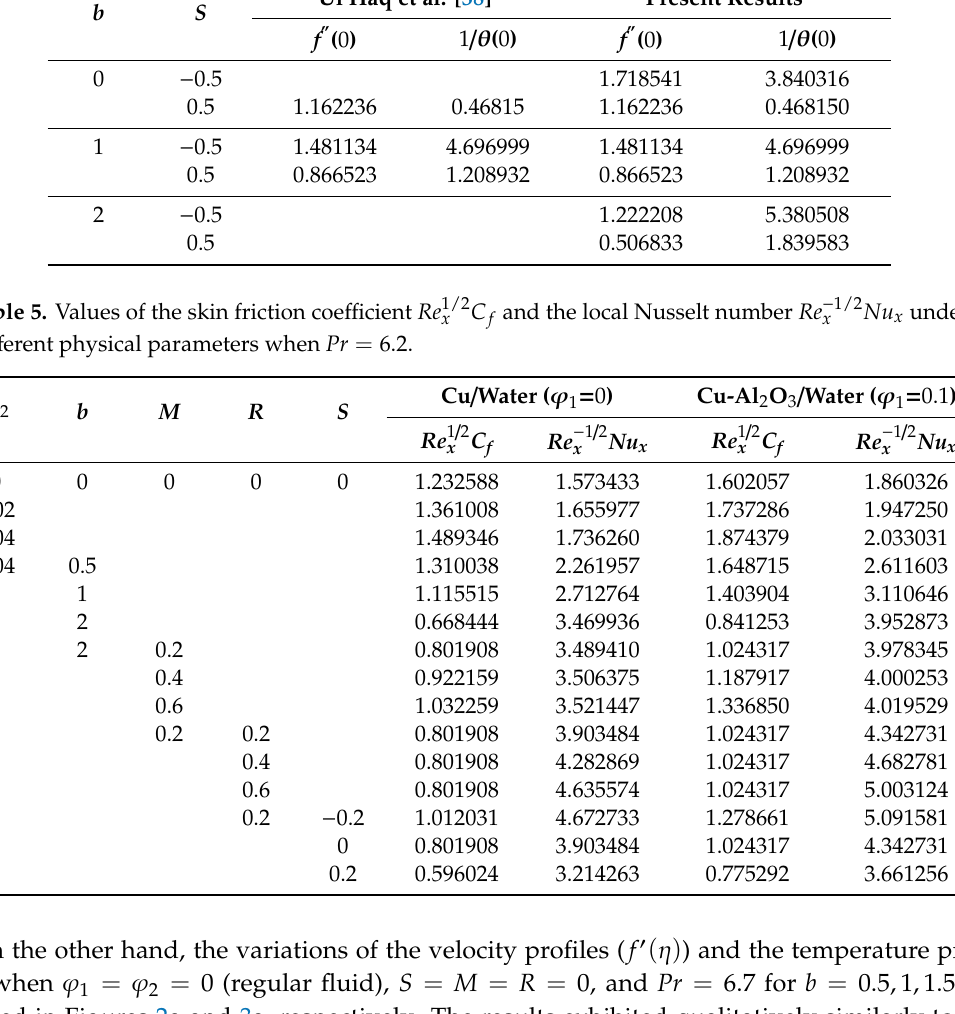
Table 4. Values of the skin friction coe ffi cient f (cid:48)(cid:48) ( 0 ) and the local Nusselt number 1/ θ ( 0 ) under di ff erent values of b and S for regular fluid ( ϕ 1 = ϕ 2 = 0) when Pr = 6.2, R = 0, and M = 0.5.